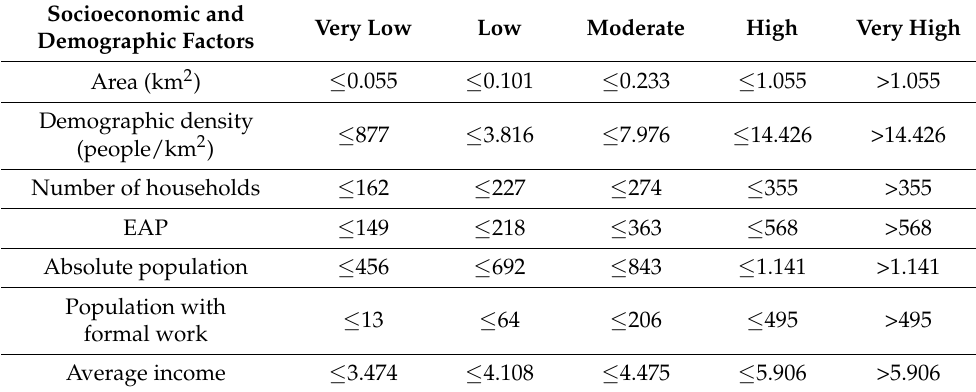
Table 1. Classification of socioeconomic and demographic factors in